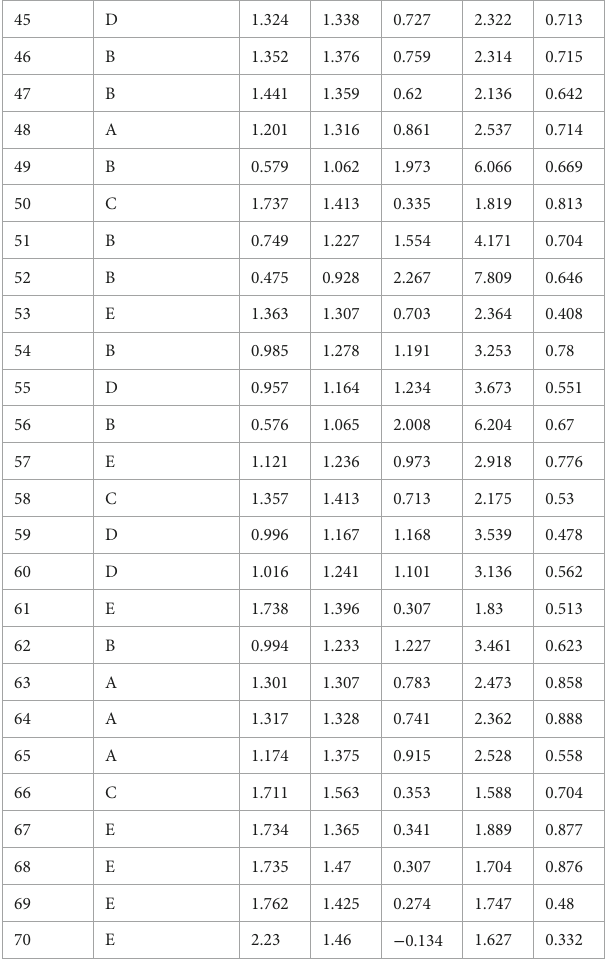
TABLE 2 Descriptive statistics of the JAS-70 items and scales. Item-